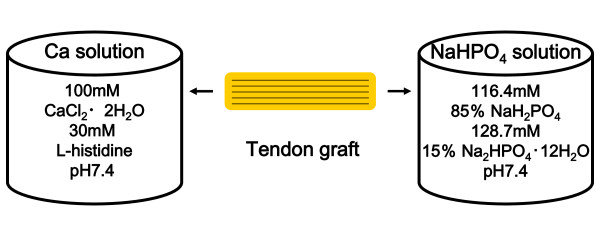
Schema of CaP hybridization method. Flexor digitorum longus (FDL) tendon is soaked in a Ca solution (100 mM CaCl2 + 30 mM L-histidine, pH 7.4, 280 mOsm/l). The grafts are subsequently soaked in a NaHPO4 solution (116.4 mM NaH2PO4:128.7 mM Na2HPO4 12H2O = 15%:85%, pH 7.4, 280 mOsm/l). The temperatures of the solution and room are both 25°C. Before each soaking, the grafts are washed in a saline solution. This cycle is repeated ten times.